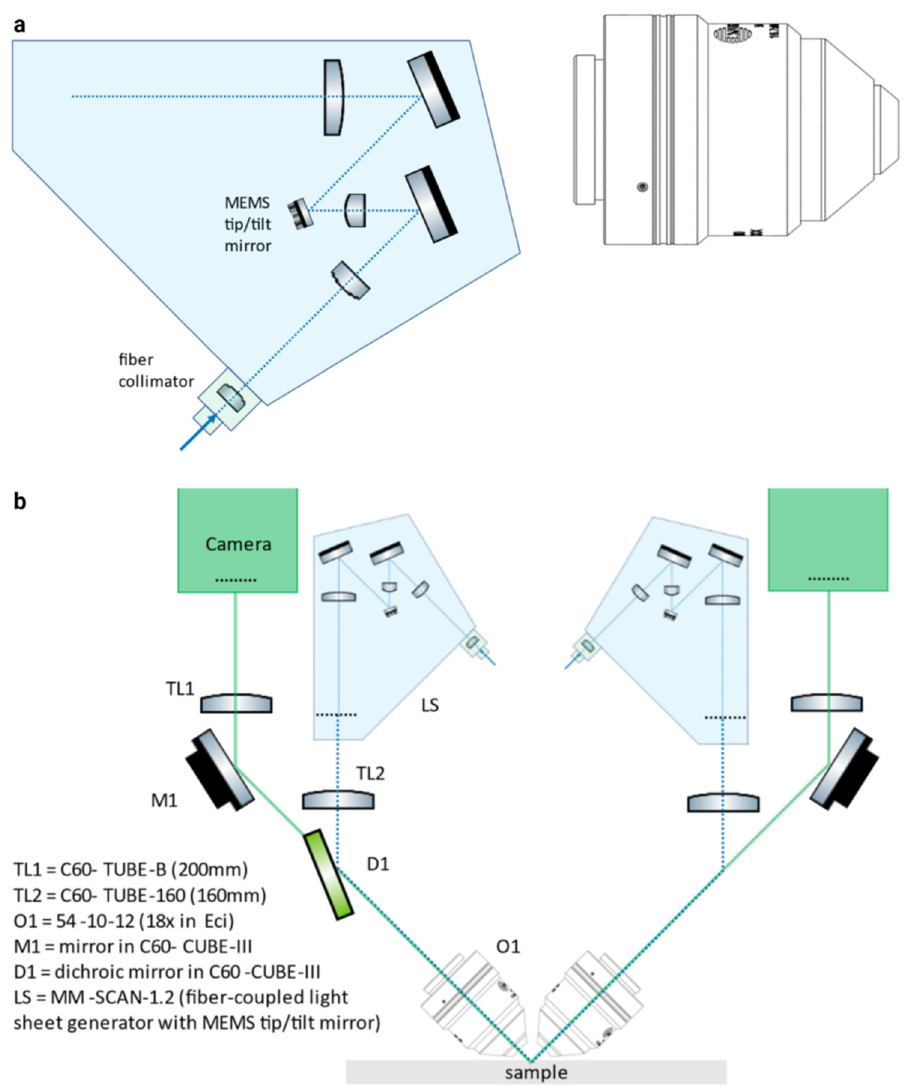
Fig. 9 Optical layout of the ct-dSPIM. a The emitted laser light is collimated and passes through an electronically tunable (ETL) lens (C60-TUNELENS- 100, ASI) into the light-sheet “ scanner ” (MM-SCAN-1.2, ASI). The ETLf allows the axial position of the beam waist at the sample to be electronically controlled. Legend continued on the next page. The scanner contains a 2D MEMS mirror, which sweeps the Gaussian beam across the sample once per camera image to form a “ virtual ” or “ digital ” light-sheet. The other axis of the MEMS mirror is used to adjust the light-sheet coincident with the detection objective ’ s focal plane. b The imaging paths are the two possible light paths (paths A and B). For each path, the scanner is on one side, and the imaging piezo and camera are on the opposite side. The light travels through the different components, such as the dichroic mirror and emission fi lter, as depicted (excitation paths: blue dotted line; emission paths: solid green line). The fi ltered fl uorescence is focused onto a 2048 × 2048 pixel sCMOS camera (ORCA- Flash4.0 V3, Hamamatsu) by a tube lens (C60-TUBE-B, ASI; f = 200